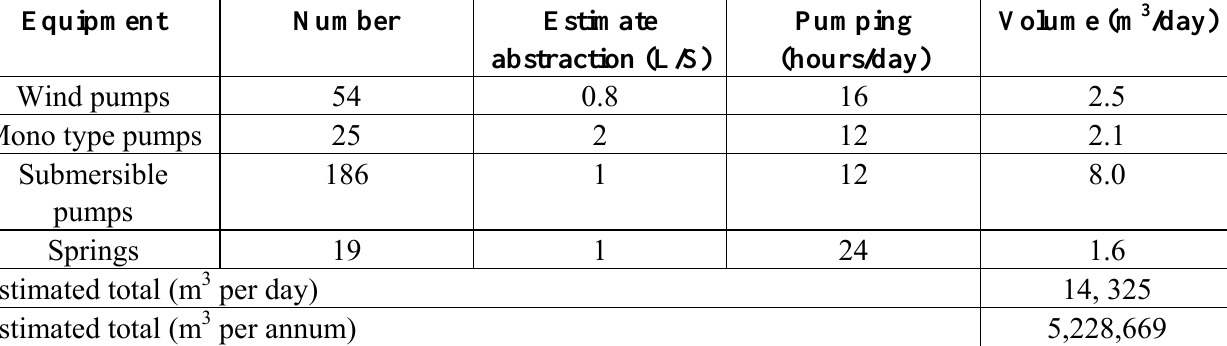
Table 3. Current abstraction and spring flow